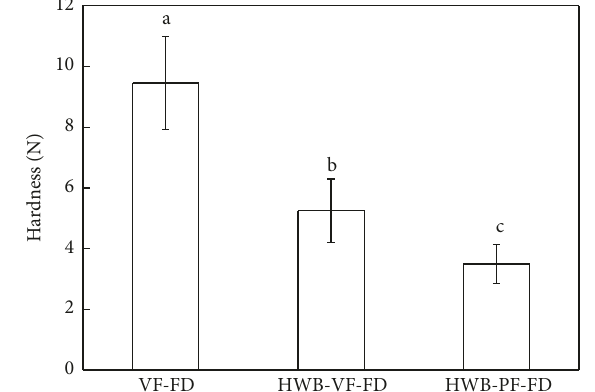
Figure 6: Hardness of freeze-dried samples in 3 freeze-drying methods. VF-FD: apple samples without hot-water pretreatment were performed with vacuum freezing treatment and freeze-drying process; HWB-VF-FD: apple samples with hot-water pretreatment were performed with vacuum freezing treatment and freeze-drying process; HWB-PF-FD: apple samples with hot-water pretreatment were performed with plate freezing treatment and freeze-drying process. Note . Different letters on the same bar indicate significant differences at 𝑝 = 0.05 by Tukey’s HSD